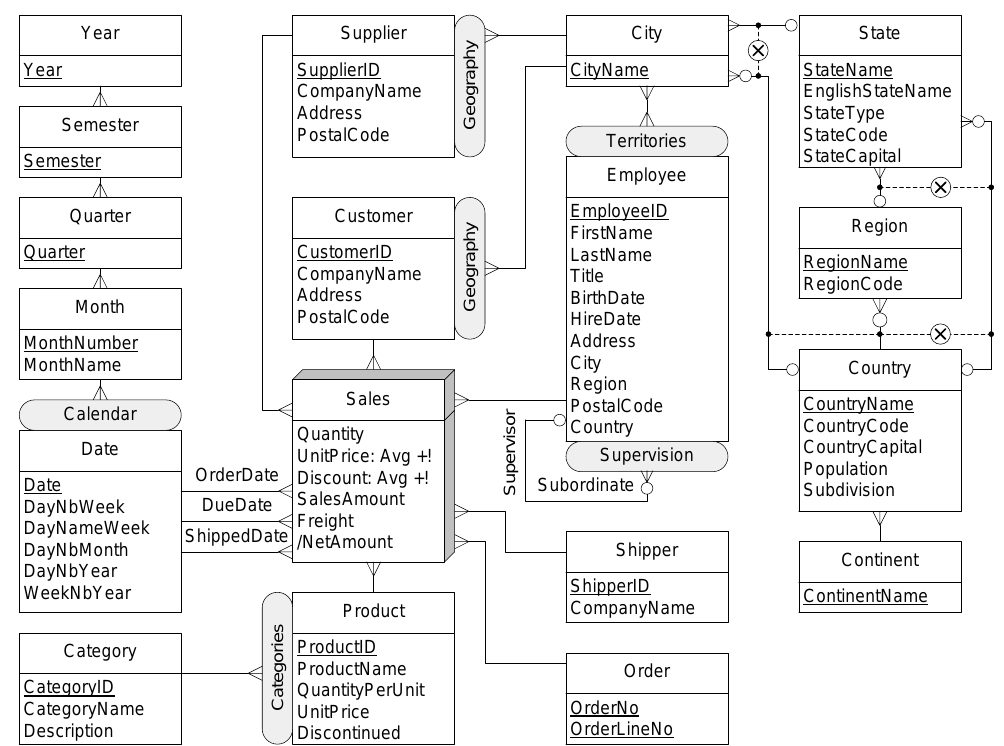
Figure 5. Conceptual schema of the Northwind data